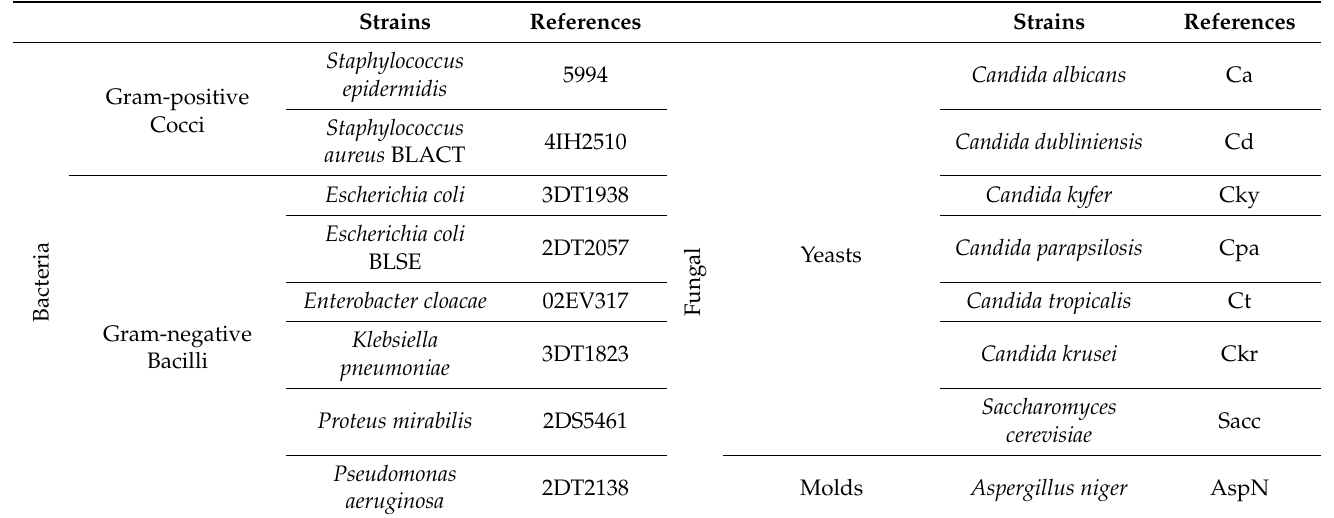
Table 17. List of bacterial strains tested with their